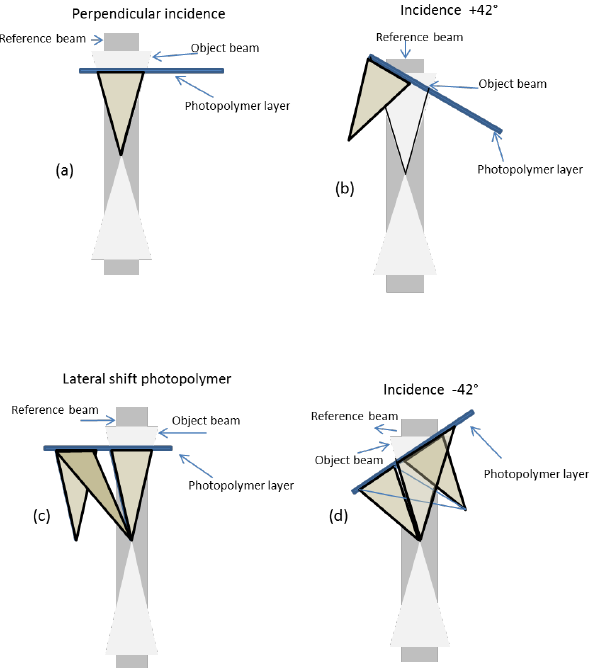
Figure 13. Recording approach for a couple of holographic lenses recorded on the same area. Writing lens for a perpendicular ( a ), +42 ( b ), lateral shift and perpendicular ( c ) and − 42 ( c ) incidence ( d ). In this configuration, a couple of in-line and off-axis overlapped lenses was rec- orded, as shown in Figure 14. To record the off-axis lenses, the flat mirror of the re- cording set-up (optical element no. 8 in Figure 5a) was rotated.